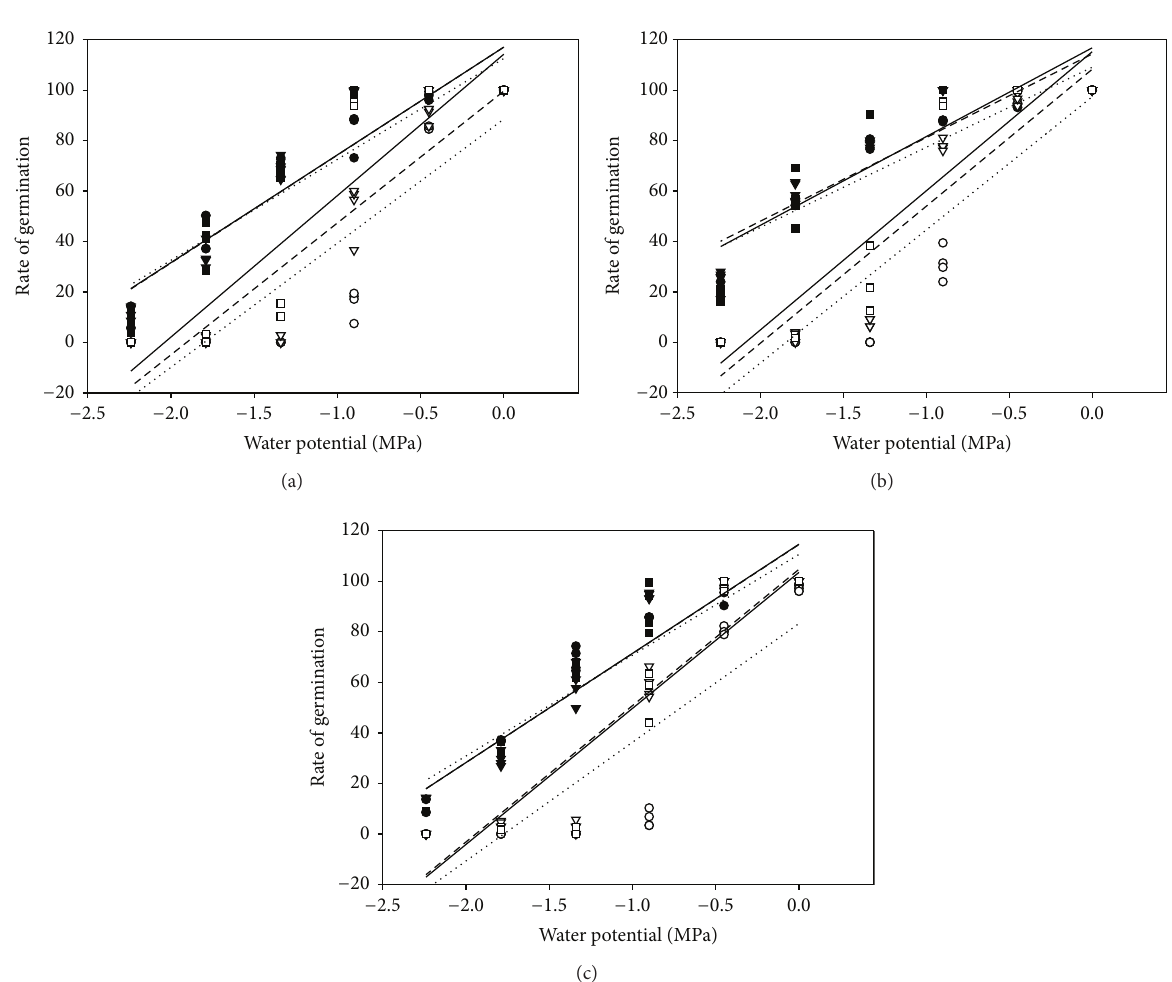
Figure 5: The relationship between rate of germination and the water potential under different temperature regimes in DX (a), SDM (b), and LK (c). Dotted line: 10–20 ∘ C NaCl ( ∙ ) and PEG ( ∘ ); short dash line: 15–25 ∘ C NaCl ( 󳶃 ) and PEG ( 󳶚 ); solid line: 20–30 ∘ C NaCl ( ◼ ) and PEG ( ◻